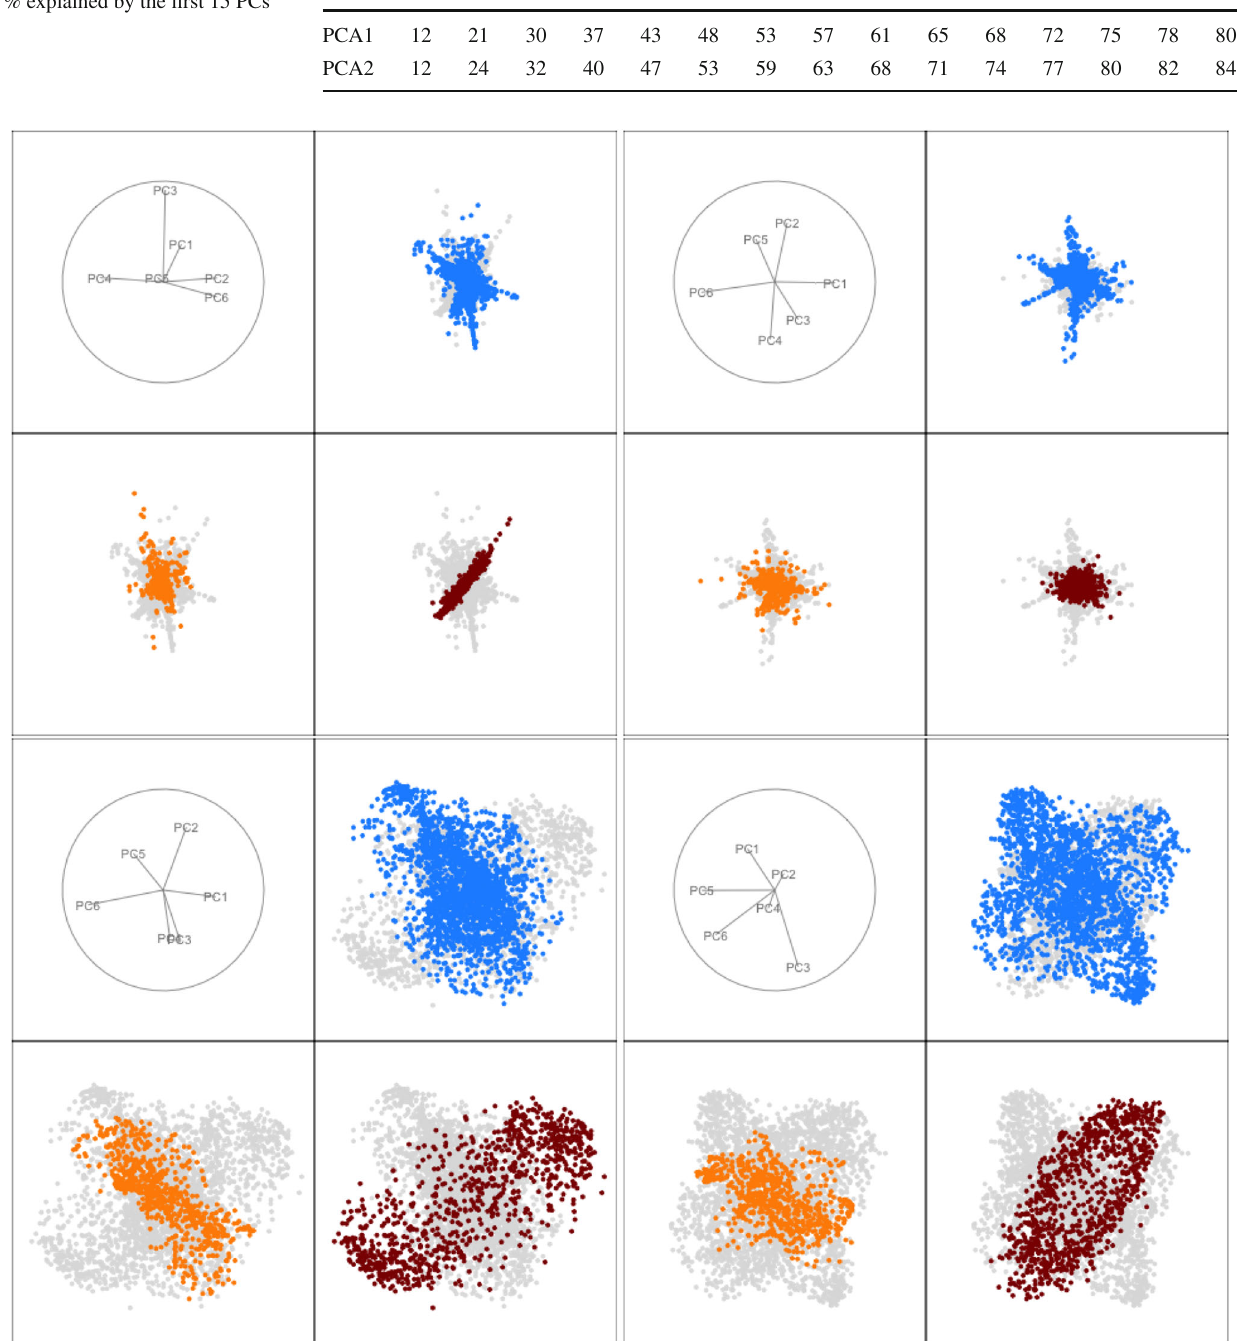
Fig. 6 Selected views from the grand tour results of the full dataset. The data points are grouped into DIS, VBP and jets cluster, shown in blue, orange and red respectively. Top left plot shows the projection of the PCs, and other plots show the three subgroups. Colour indicates group, and grey shows the entire data set, as a reference in order to make